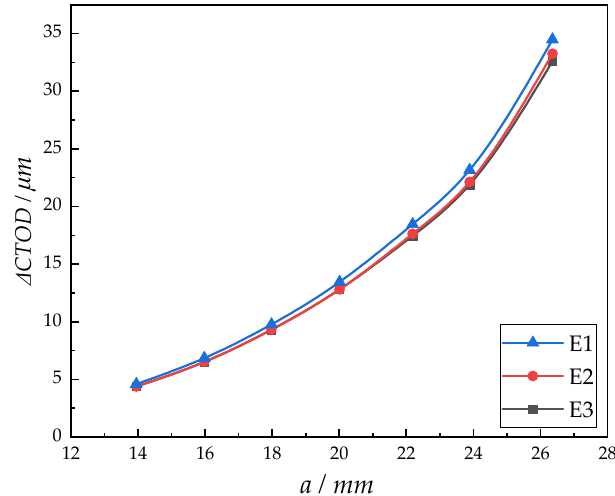
Figure 5. Measurement results with different ranges of extensometers (CT06).